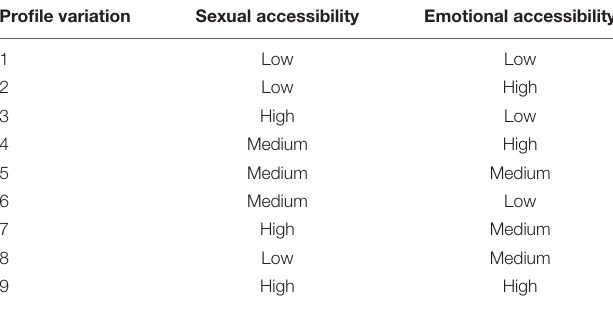
TABLE 1 | Orthogonal array of partner profiles and their respective attribute variations.